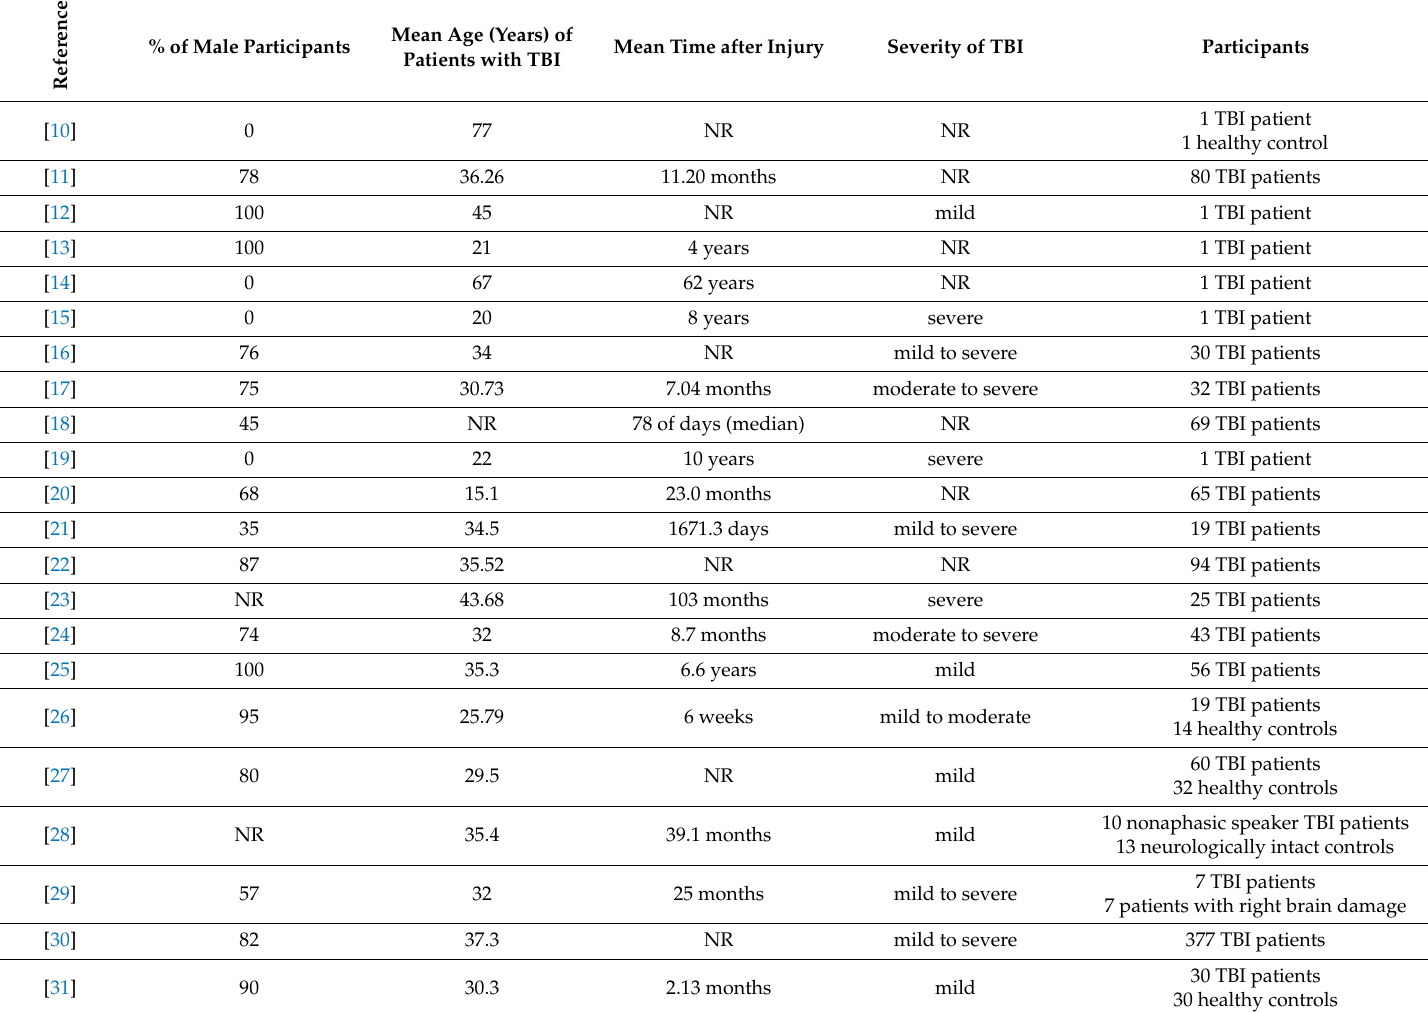
Table 3. Characteristics of samples ( n =